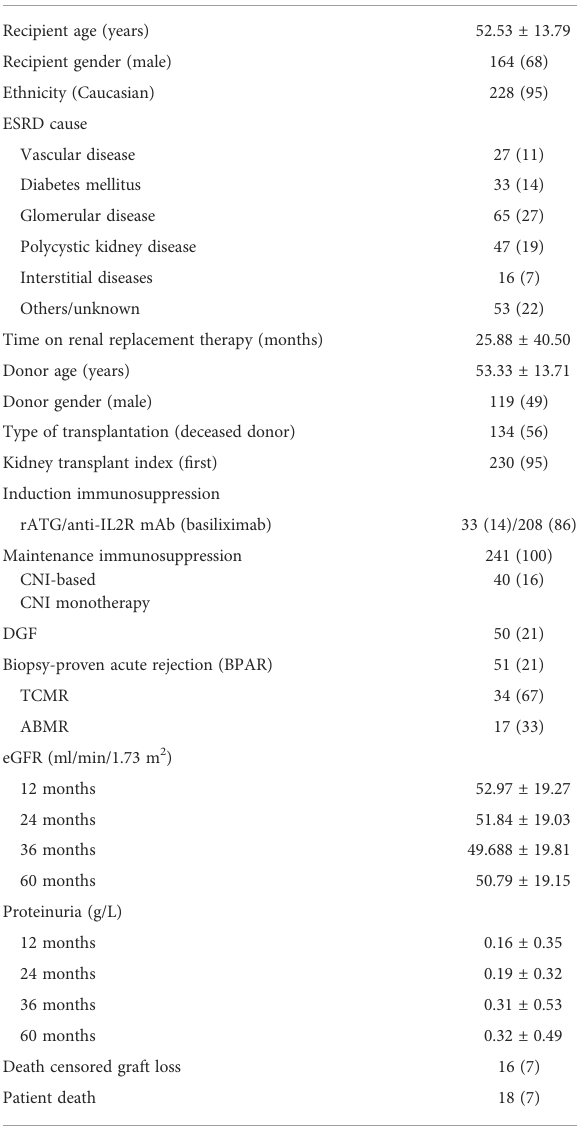
TABLE 1 Demographic and clinical characteristics of patients included in the study.